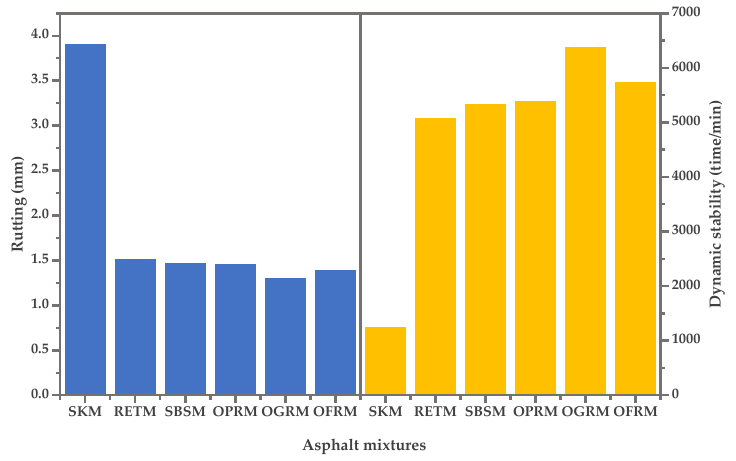
Figure 8. Wheel tracking test results of asphalt mixtures.